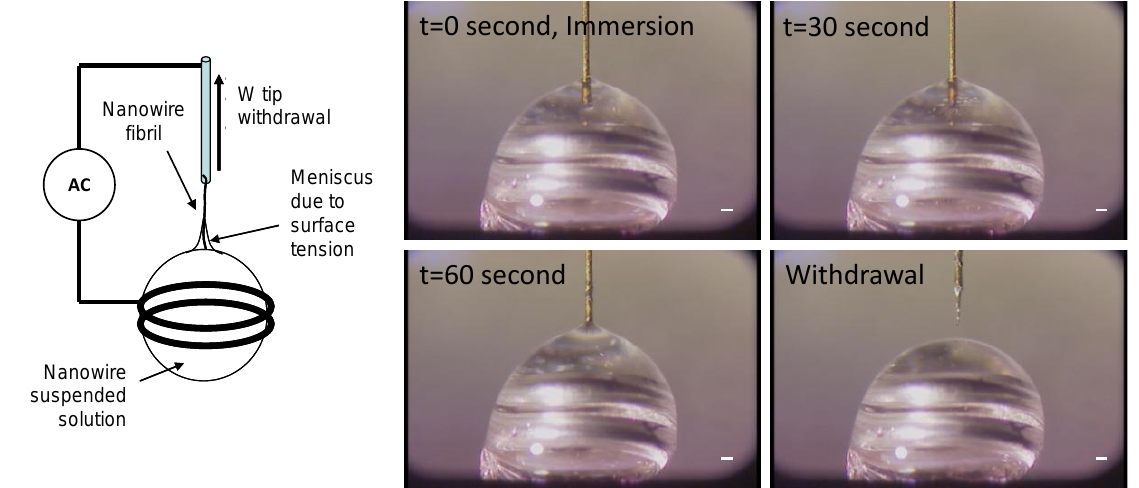
Figure 8. Sequential images of 15 µm-long nanowires one-dimensional assembly by using tungsten (W)-tip using dielectrophoresis. Applied voltage is 20 V bar is 100